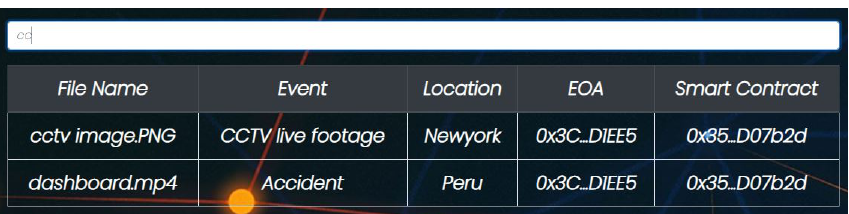
Figure 20. Keyword